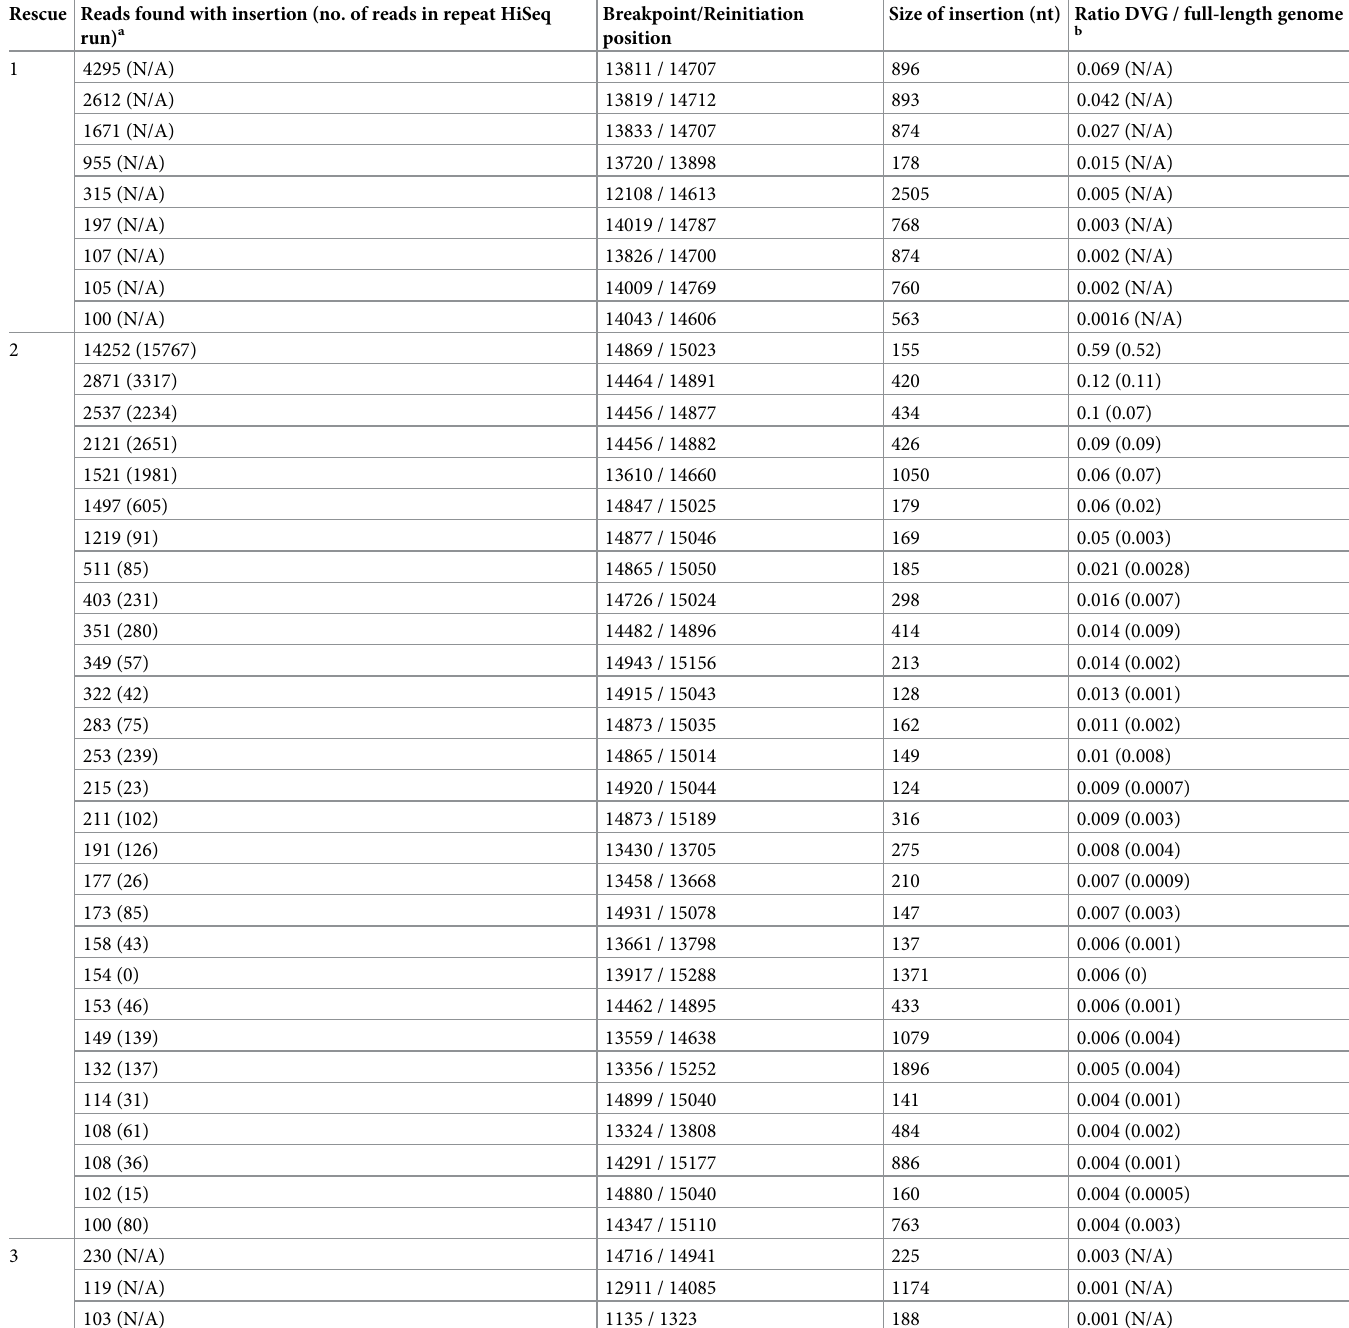
Table 4. Insertion- type DVGs identified in viruses #1, #2 and #3 using DVG-profiler. Rescue Reads found with insertion (no. of reads in repeat HiSeq run)